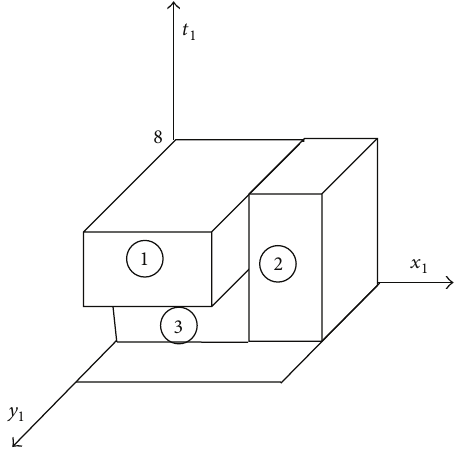
Figure 7: The status of place 1 while activity 15 is put.